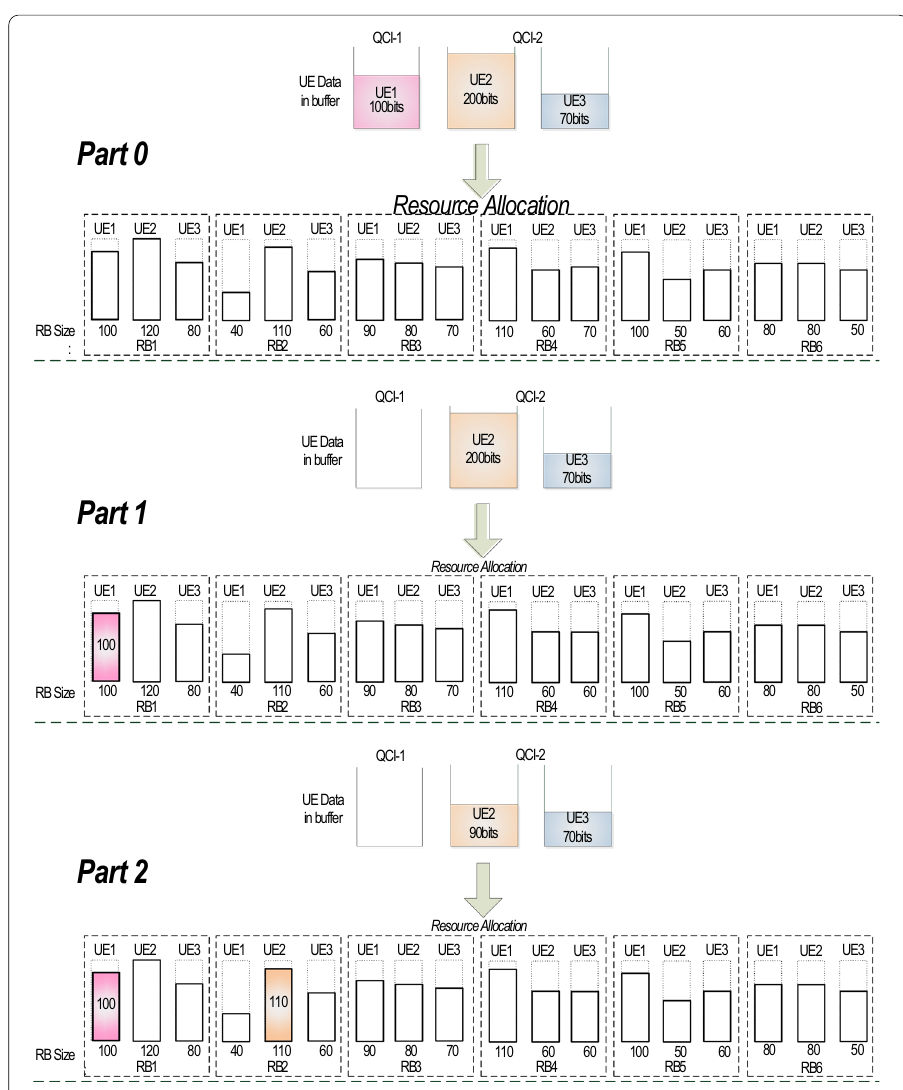
Fig. 3 Example of traditional resource allocation with QCI priority consideration; Example case of LTE resource allocation in the MT scheduler with the priority queue